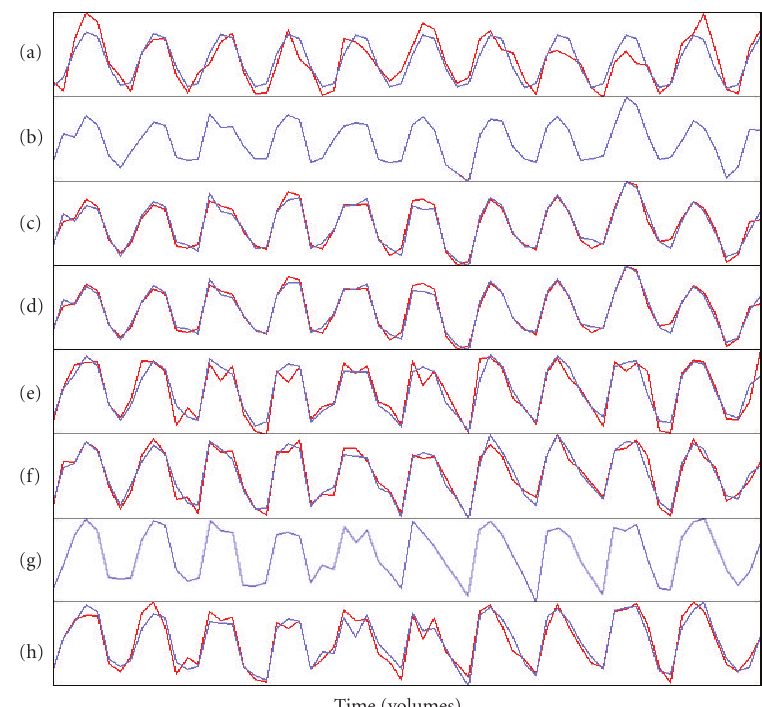
Figure 10: Time courses derived from Subject 1’s fMRI data using (a) task-related GLM; (b) single-voxel hybrid method (SV); (c) few-voxel hybrid method (FV); (d) many-voxel hybrid method (MV); (e) dual regression, single IC hybrid method (DRS); (f) dual regression, all IC hybrid method (DRA); (g) back-reconstruction with Infomax (BR-I); and (h) dual regression, single IC hybrid method, Infomax group IC seed source (DRS-I). Blue lines: time courses from linear model. Red lines: fMRI data where deviating from model, at voxel with best fit to model.